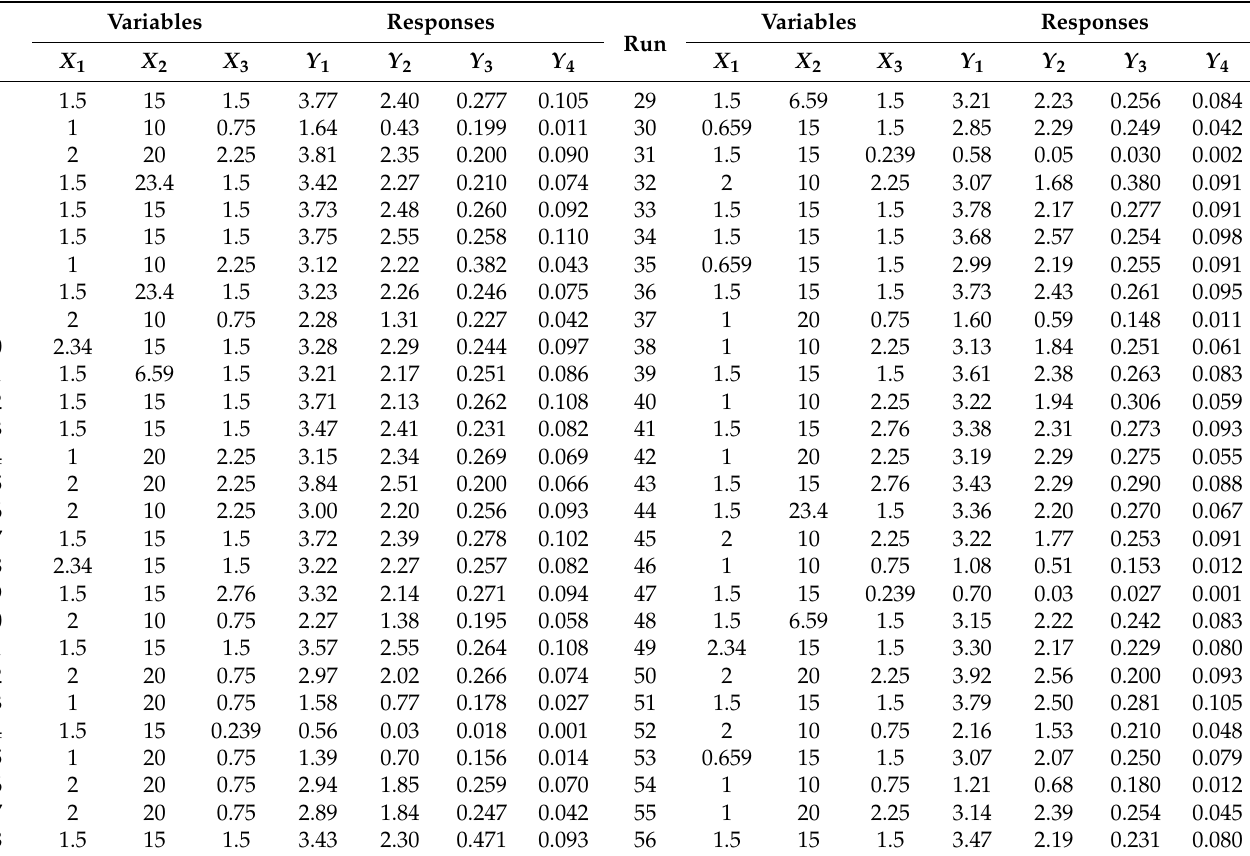
Table 2. Results of CCD for the saponification